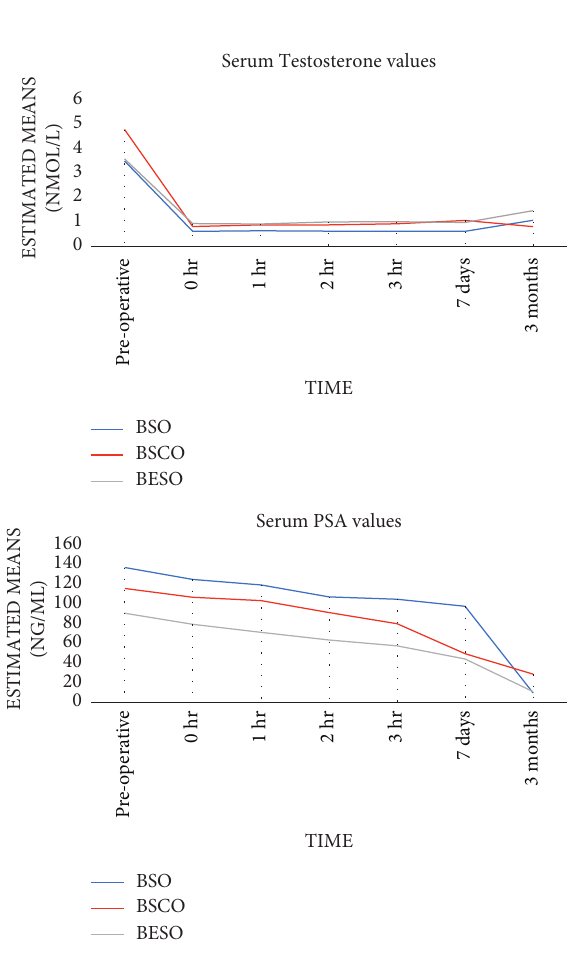
Figure 5: Serum testosterone and PSA trend over time (repeated measures ANOVA with Greenhouse–Geisser correction).